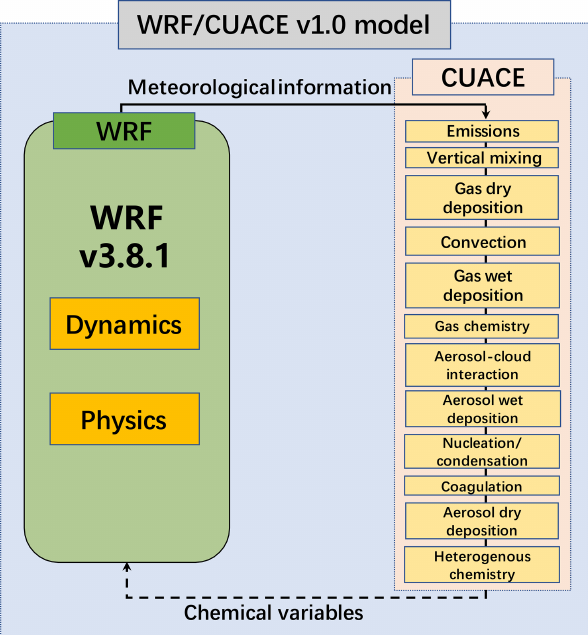
Figure 1. Schematic of modules in the WRF/CUACE v1.0